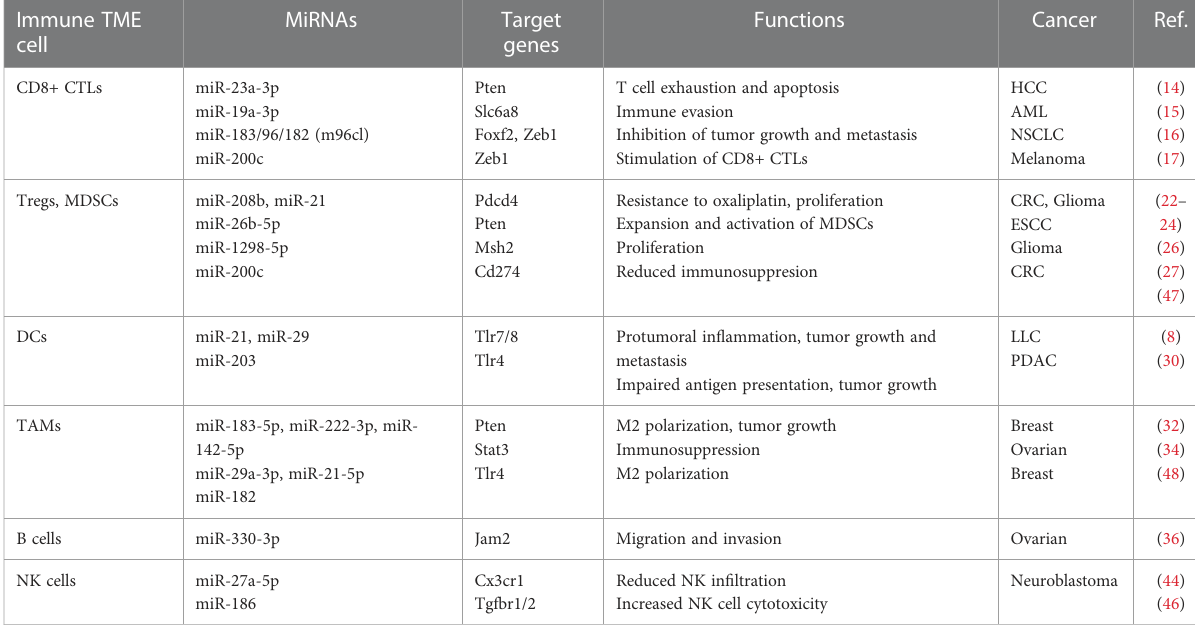
TABLE 1 Summary of miRNA functions in the